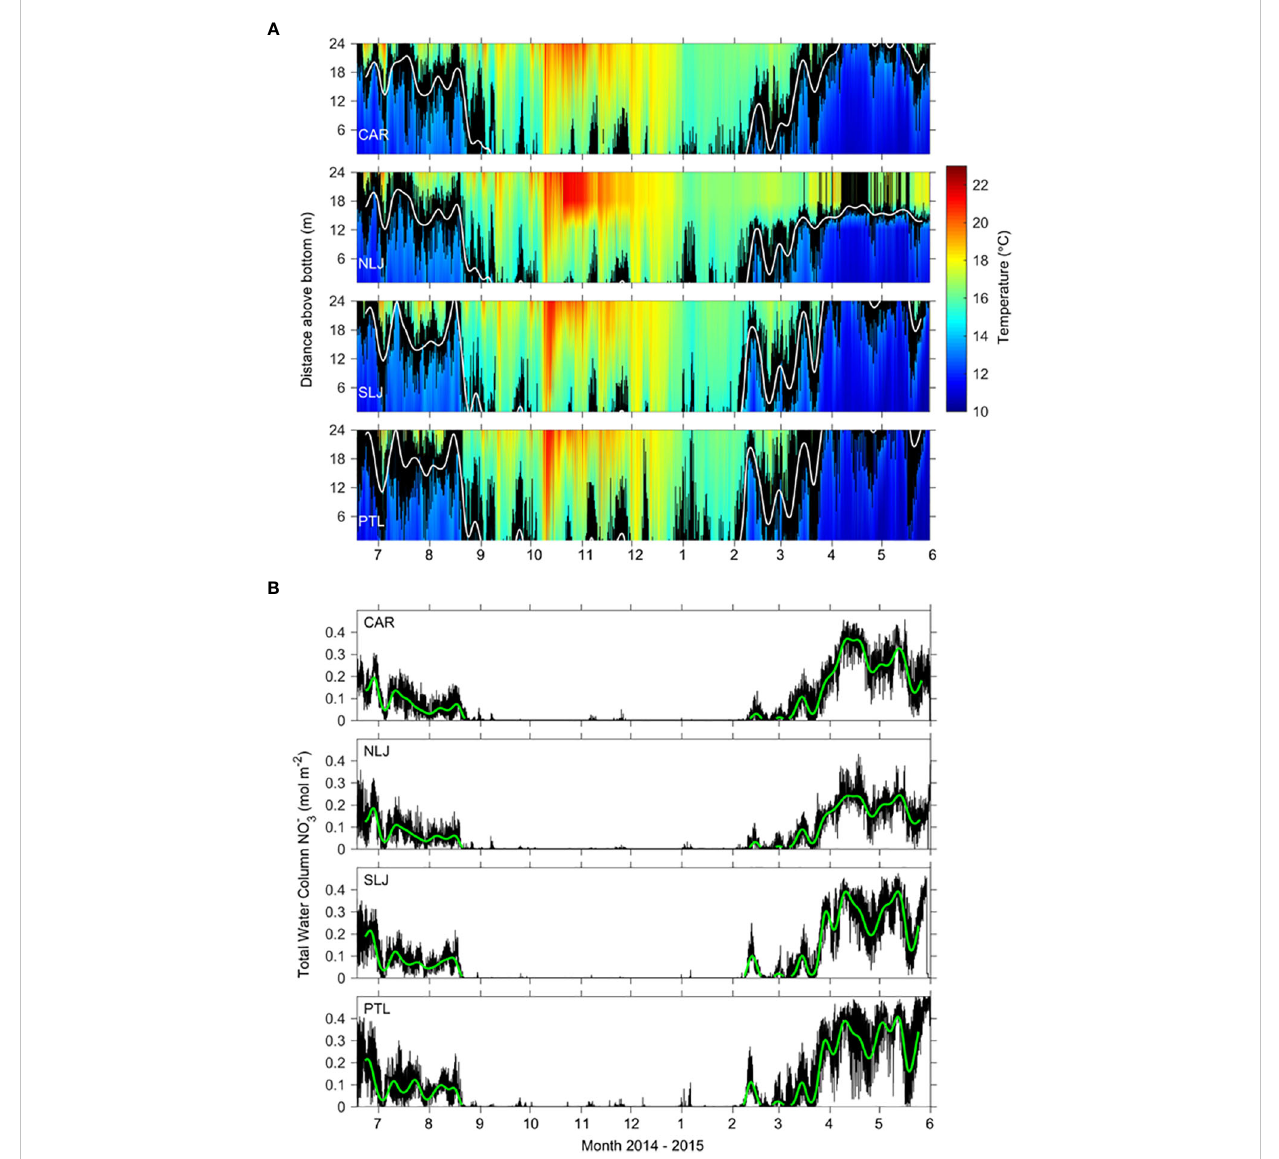
FIGURE 4 (A) Continuous record of water column temperatures June 2014 through May 2015 at 4 coastal study sites at 1 min intervals for the lower 24 m of the water column above the sea fl oor at 36 m bottom depth. Color shows interpolated temperature indicated by color bar at right. Black lines indicate vertical position of the 14.5 °C isotherm in raw data; white lines indicate vertical position of 14.5 °C isotherm for 10-d fi ltered data. (B) Water column integrated nitrate (NO 3- ) predicted from temperature; black lines show water column NO 3- based on 1-min temperature data, green lines show water column NO 3- based on 10-d fi ltered temperatures.